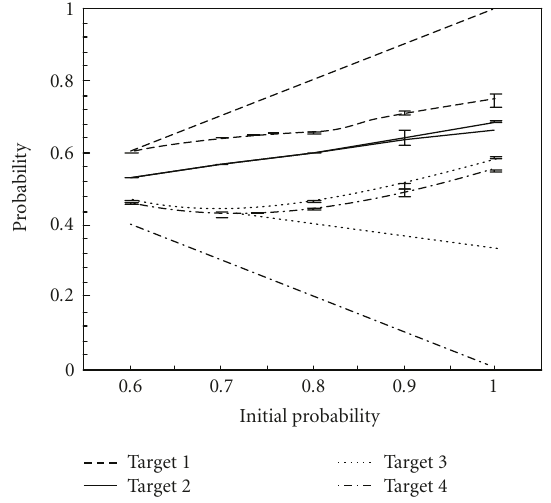
Figure 4: The convergence property of initial probability for sub- ject CC. In this figure, we draw the mean values of the convergent probabilities and mark them with standard deviations at di ff erent initial values. For comparison, we also depict the curves of initial